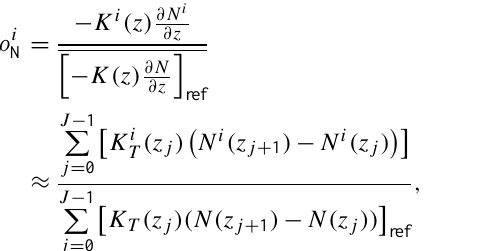
Fig. A.1: CTD data at Station 7 (36.3N 13.5W) July 21, 2009, 11am. Depth profile of the Chl- a concentration (green line), depth profile of the corrected irradiance (blue line), and surface irradiance at the time of the measurement at depth (red line). The light blue lines indicate the depth section used to extract K . The green-shaded area symbolises the phyto- bg plankton concentration which is used to determine k .